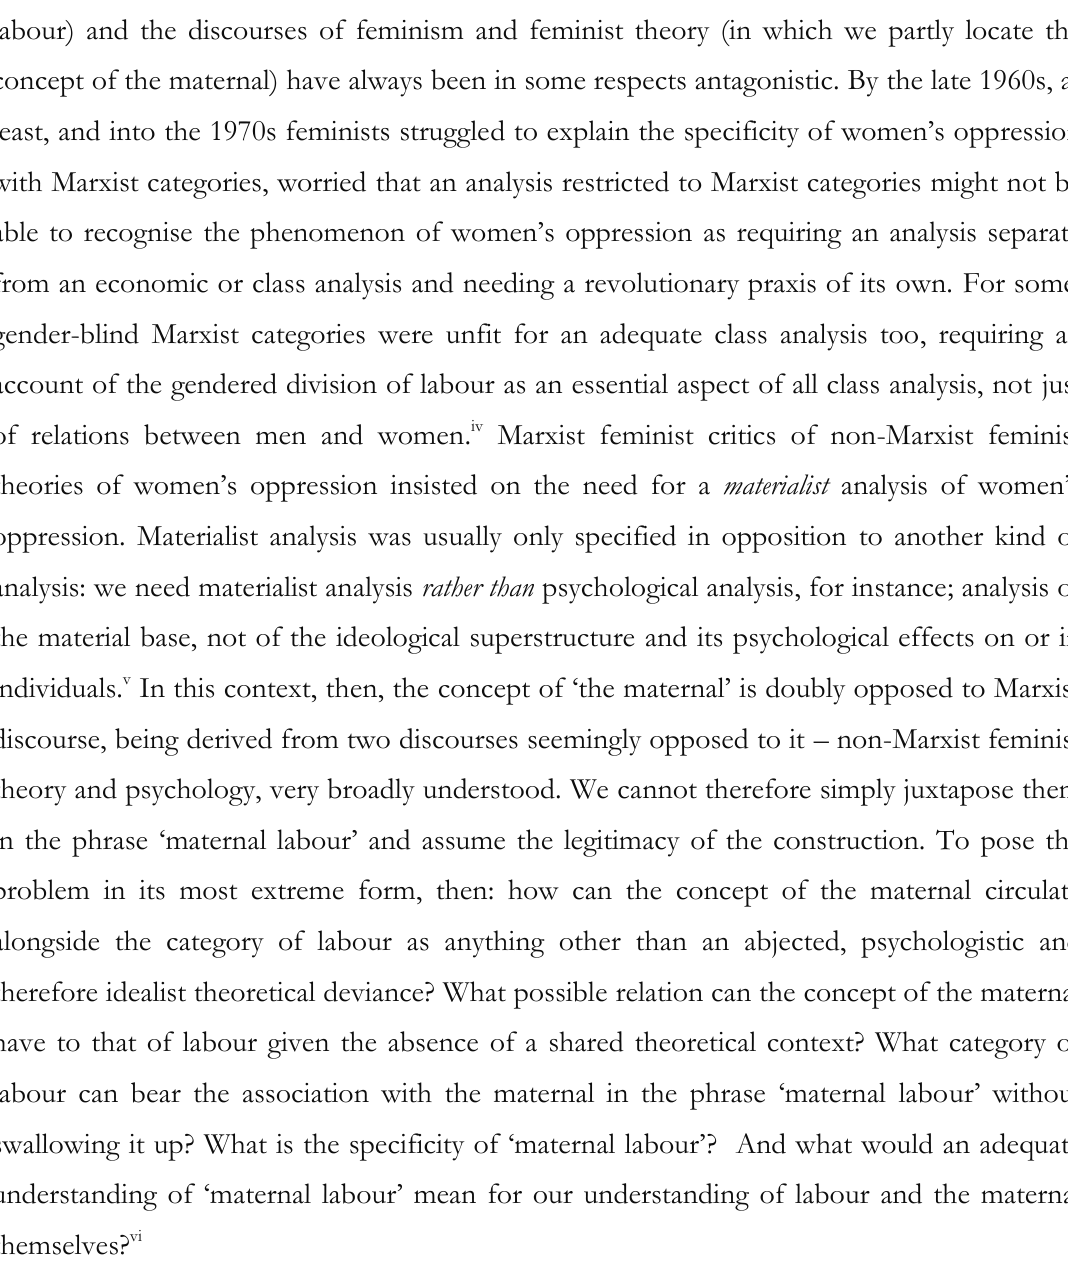
Stella Sandford, What is Maternal Labour? Studies in the Maternal, 3(2), 2011,